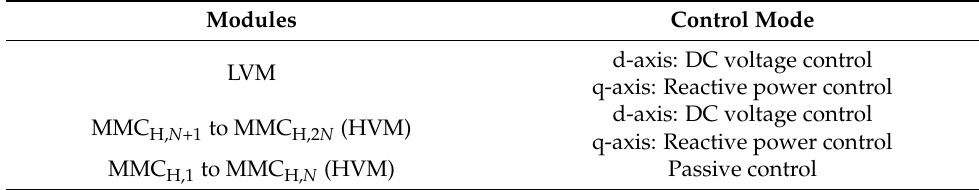
Table 1. MCAT control strategy in normal operation.